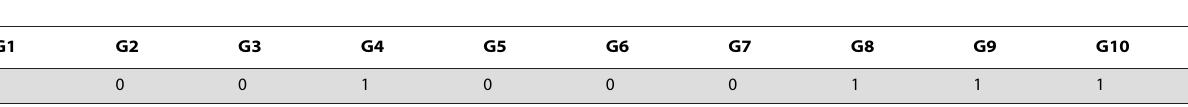
Table 7. The wild type steady state after discretization.